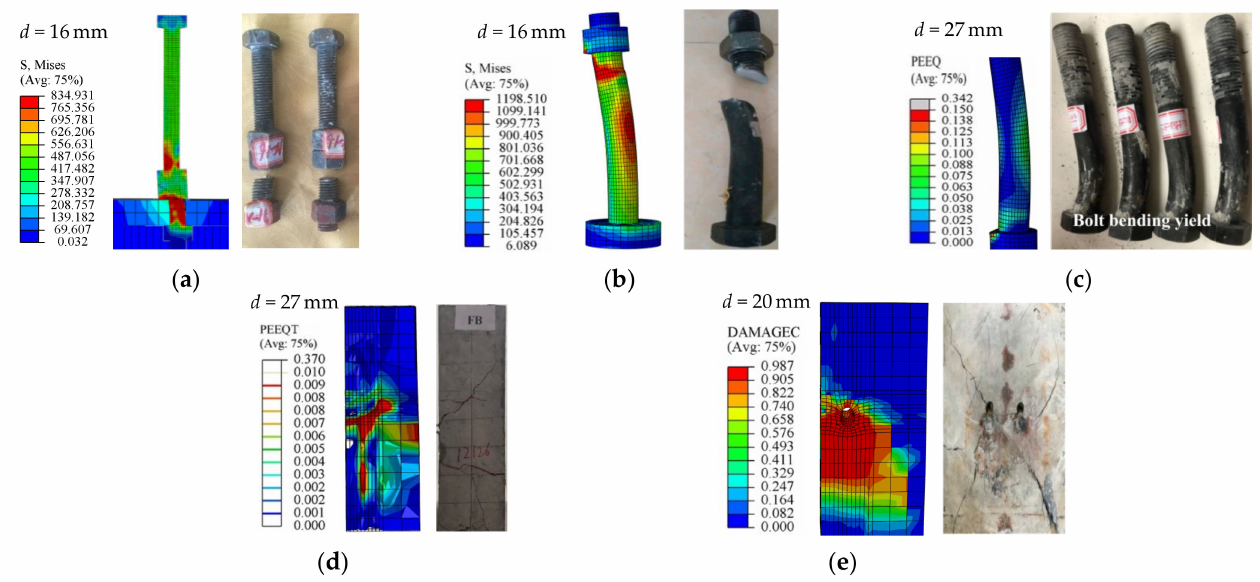
Figure 11. Comparison of the failure modes predicted by numerical models and experimental results: ( a ) bolt shear failure (T1-16 specimen); ( b ) bolt shear failure (T2-1 specimen); ( c ) bolt bending yield (NC-M27-G8.8 specimen); ( d ) concrete cracks (NC-M27-G8.8 specimen); ( e ) concrete failure (T4-1